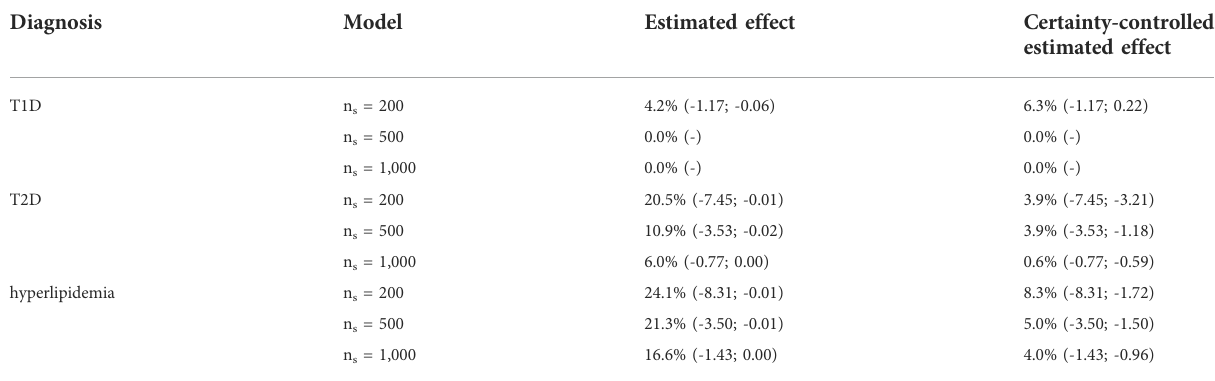
TABLE 3 Proportion (range) of negative personalized estimated effects of adherence on